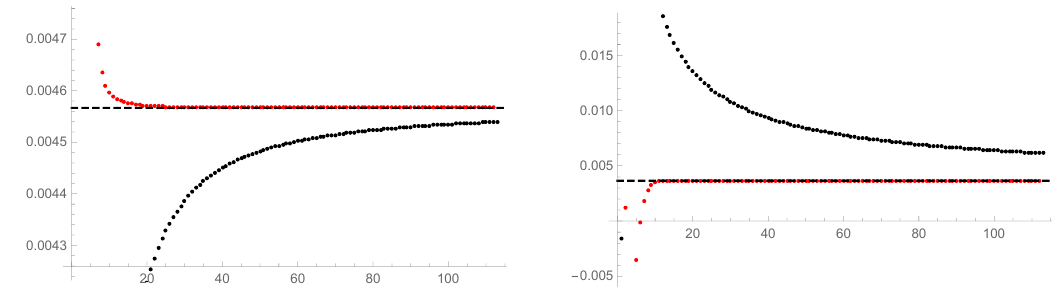
Figure 7 . Plot of sequences d k (left, black) and 2 k ( U 0 − d k ) (right, black) for the Gross-Neveu model with N = 7 as well as their respective second Richardson transforms (red). The dashed lines are the predicted values U 0 (left) and U 1